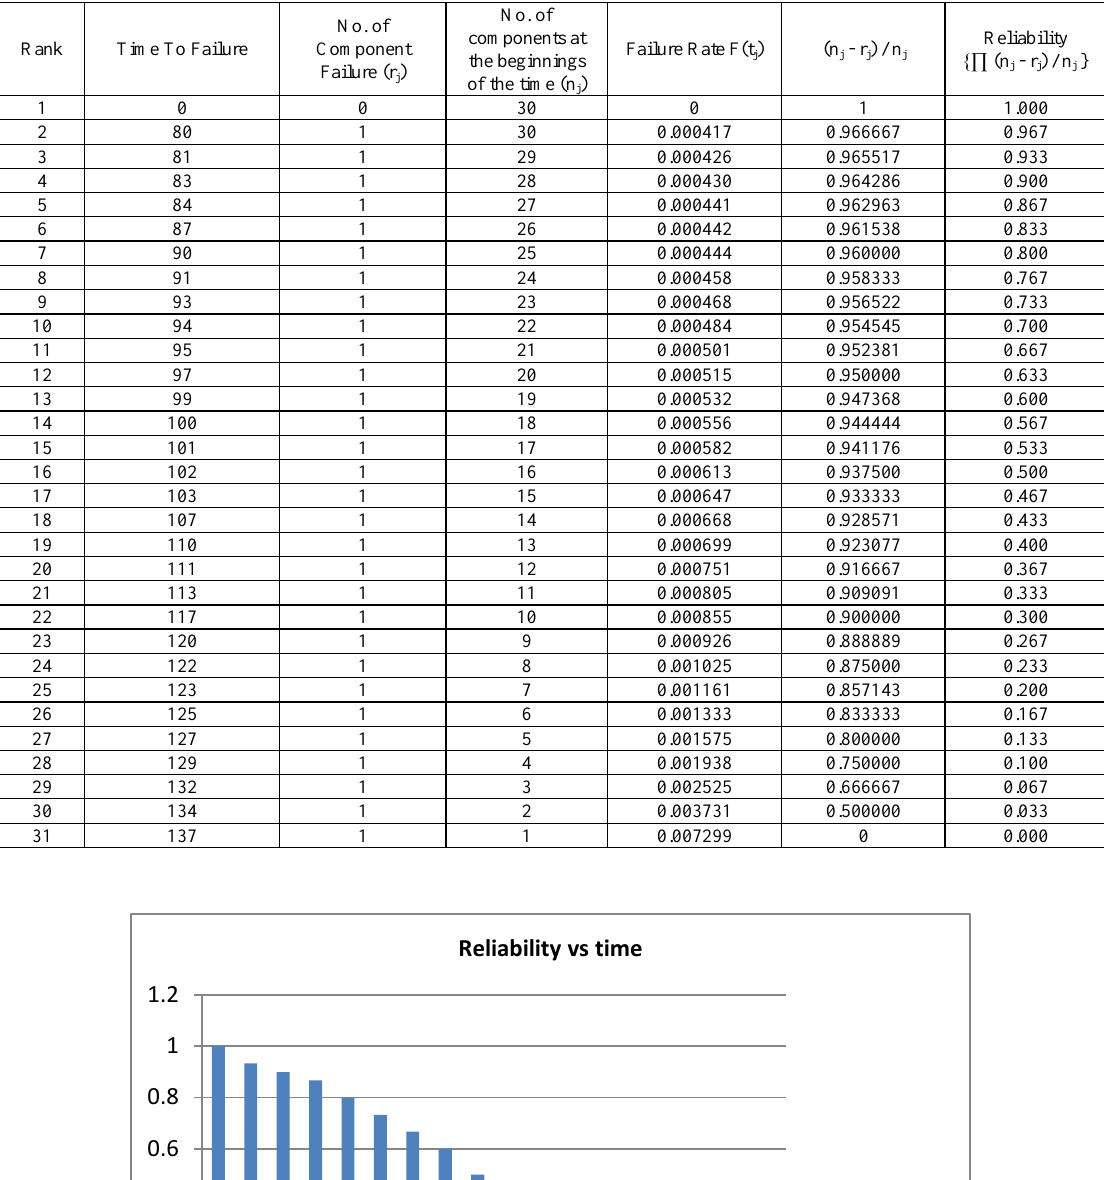
Table 2. Calculated values of failure rate and reliability using proposed approach